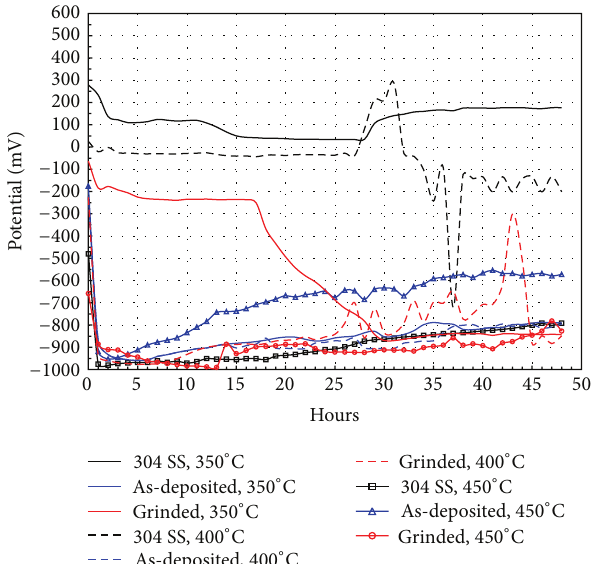
Figure 6: Current density (𝐼 different